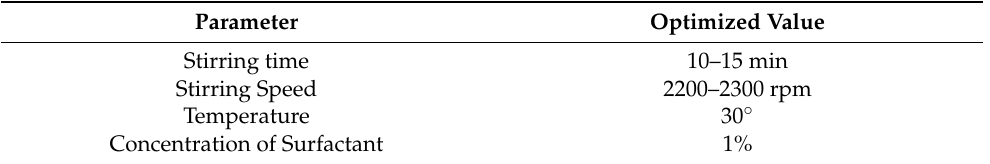
Table 2. Optimized values of fixed parameters for formulation. Process variables such as time of stirring, speed of stirring, temperature and surfactant concentration were fixed on the basis of the outcome of formulation trials carried out for initial risk assessment.